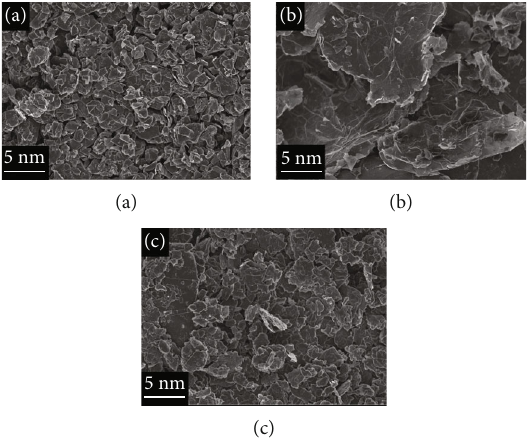
Figure 1: SEM images of (a) GP, (b) GNP, and (c) GO at mag. of 2.00k × .